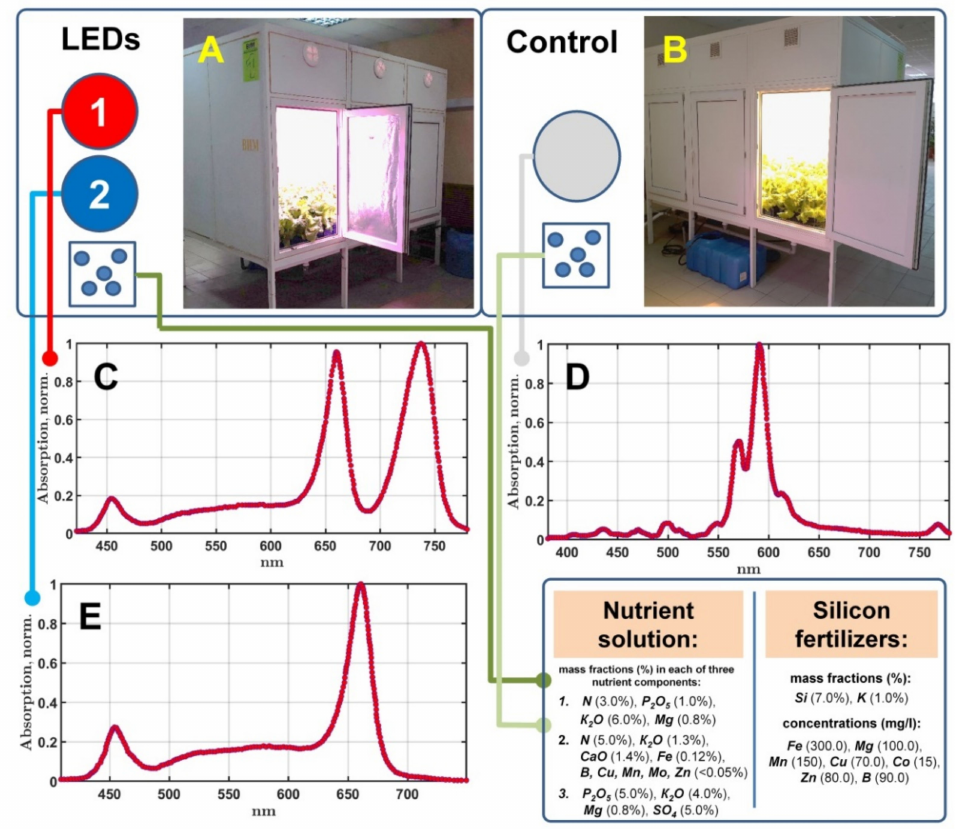
Figure 1. Scheme of the experimental setup. Two climatic chambers equipped with LEDs ( A ) or sodium lamps ( B ) and the corresponding spectra of the lighting regimes are shown in plots ( C – E